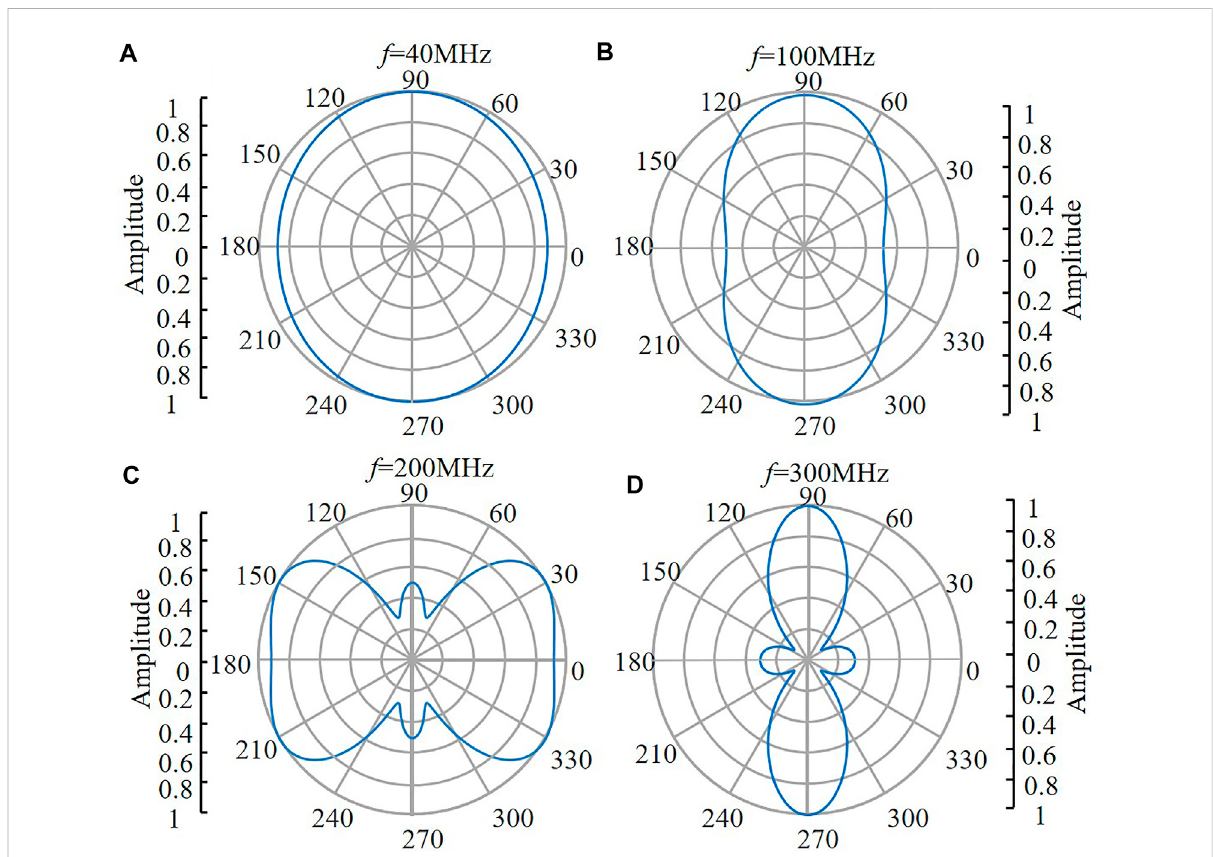
Polar distribution patterns of the photoacoustic amplitude at the near- fi eld ξ = 1.2 for various frequencies (A – D) Respectively for thefrequency of40, 100, 200,and 300 MHz. Theamplitude distributionofeachfrequencyisnormalisedto itsmaximum value,whichare0.08, 0.1, 0.03, and0.05,